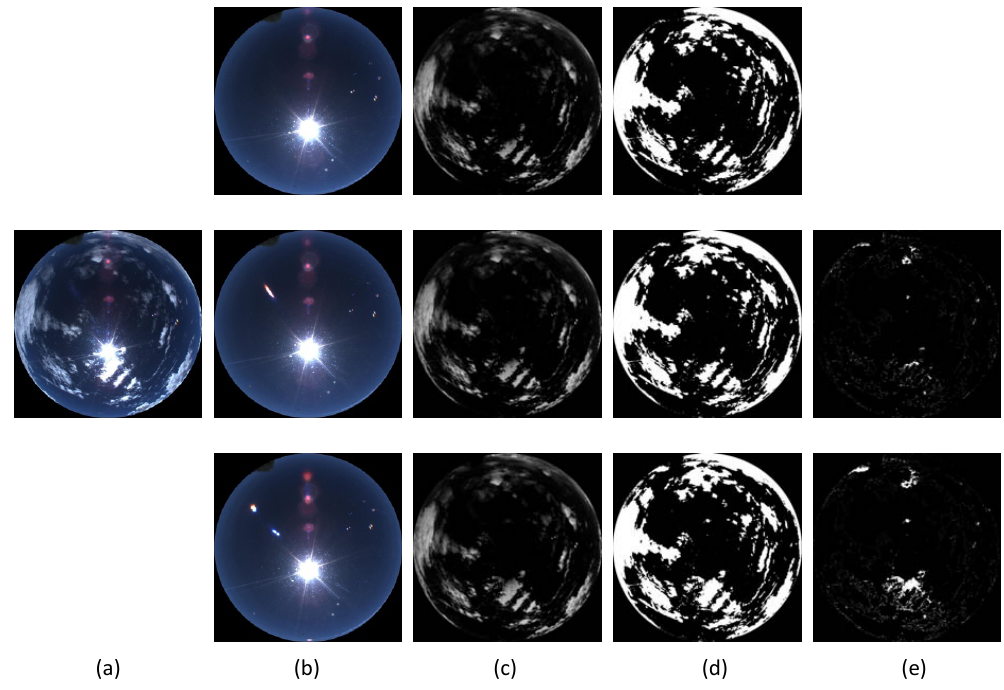
Figure 8. Sensitivity test as Fig. 6 but for high solar elevation angle. Panel (a) is the TCI image after rotation, which was obtained on 28 June 2013, (b) shows the CSB images, where the first row has the completely same solar elevation angle as (a) , the solar elevation angle of the second row has 2 ◦ deviation with (a) , and the solar elevation angle of the third row has 5 ◦ deviation with (a) , (c) shows the difference images, (d) shows the corresponding cloud detection results, and (e) represents the differencing results between the 2 and 5 ◦ offset with the baseline result in row one.